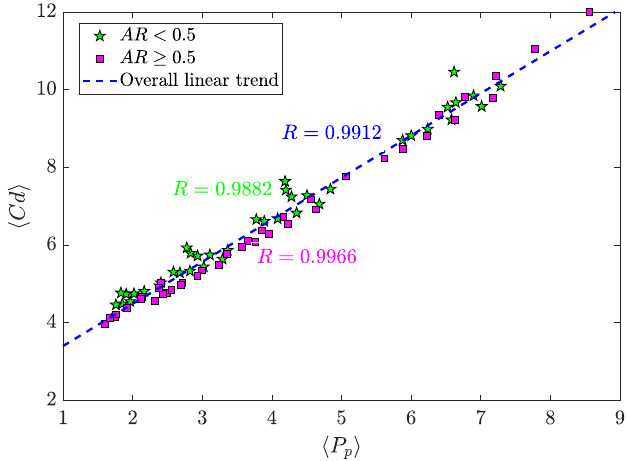
Figure 15. Pearson Correlation for (cid:104) P p (cid:105) and (cid:104) Cd (cid:105) . Please note that the correlation for each AR value has been obtained by including AR = 0.5 in both greater and lower case scenarios, to have a greater number of data in each